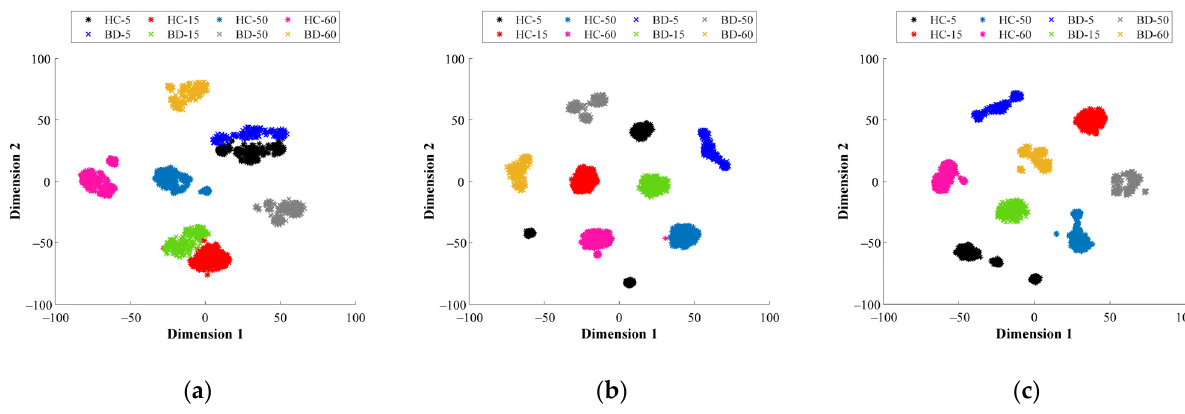
Figure 11. Resulting 2D representation of the data distribution of the mapped feature spaces by their corresponding SAE when all feature spaces domains are considered under the proposed fusion scheme (TD + FD + TFD) of all available signals (vibrations and stator current) are taken into account by the T-SNE for each different bearing technology: ( a ) metallic, ( b ) hybrid and ( c ) full ceramic. Table 8. Performance metrics of the proposed method based on SAE and SoftMax layer for the particular evaluation of each feature domain and the proposed fusion scheme.